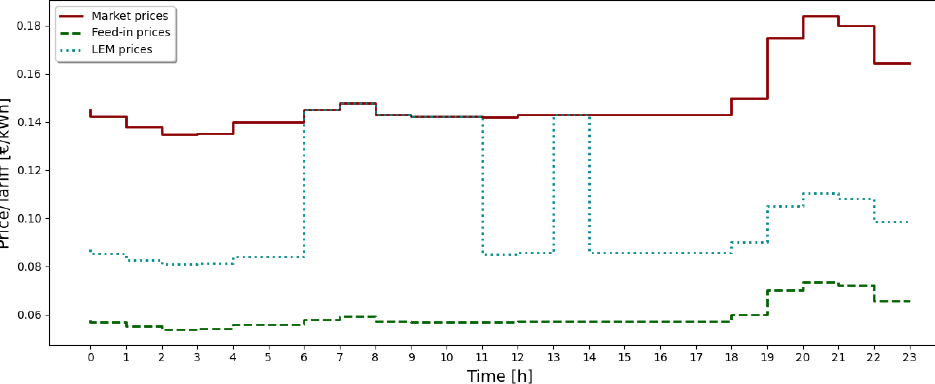
Figure 7. Community tariffs and prices for the simulated